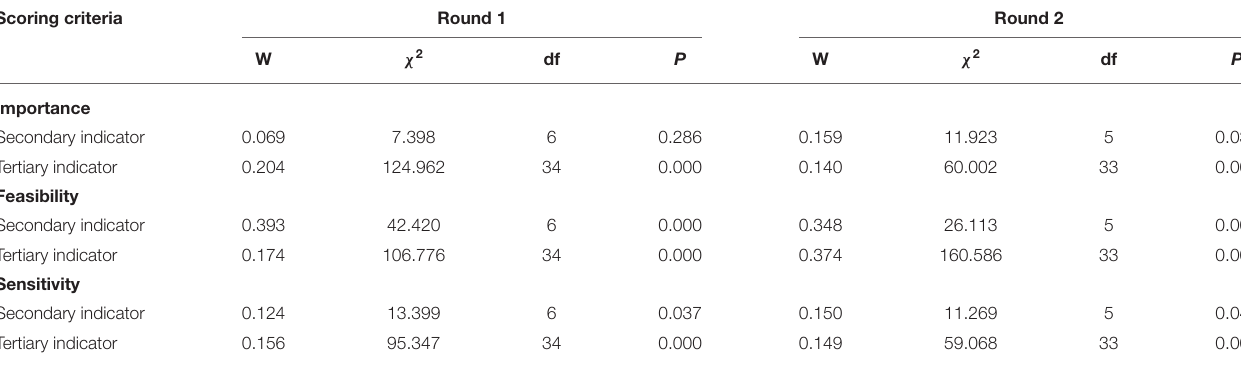
TABLE 4 | Kendall’s W for indicators in the Delphi process. Scoring criteria Round